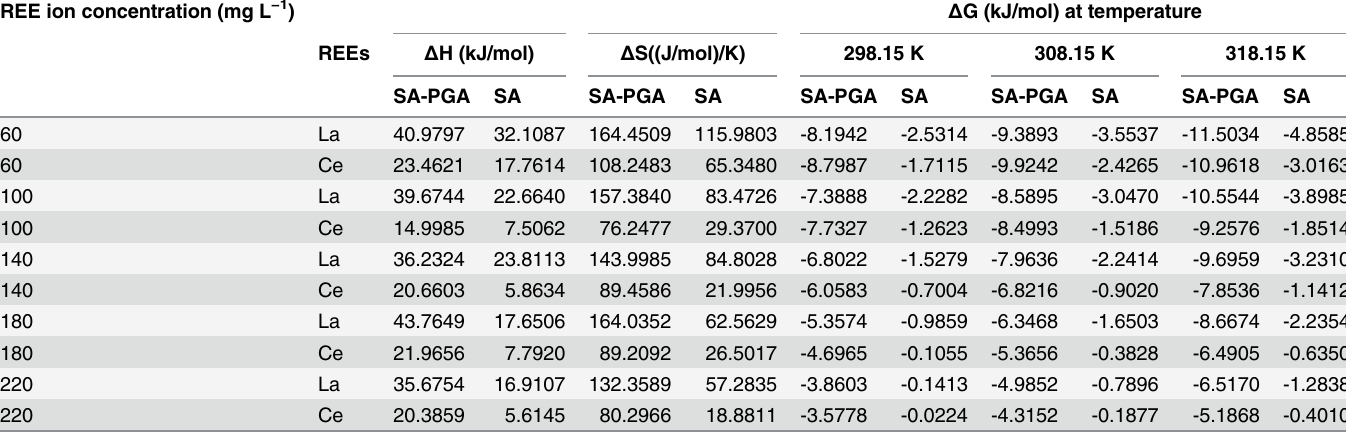
Table 4. Thermodynamic parameters for the adsorption of REEs on the gel particles. REE ion concentration (mg L − 1 )